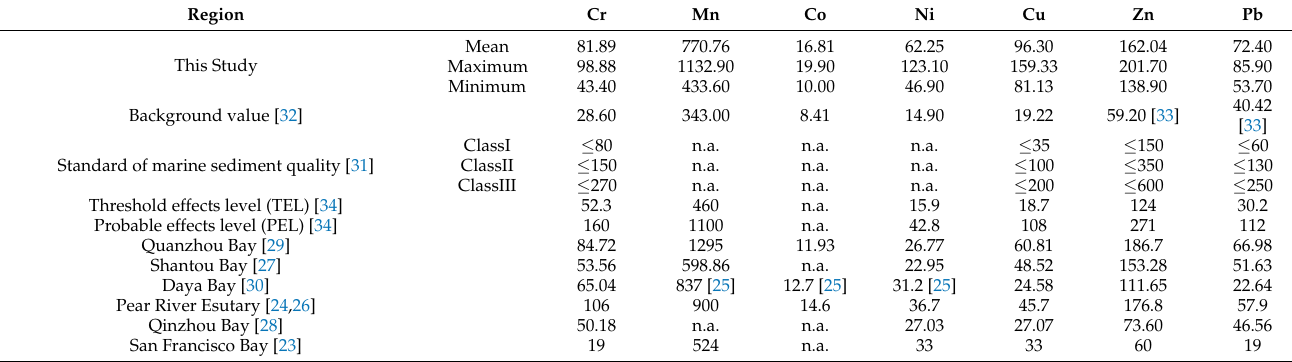
Table 1. Heavy metal concentrations in surface sediments of Zhelin Bay (mg/kg dry